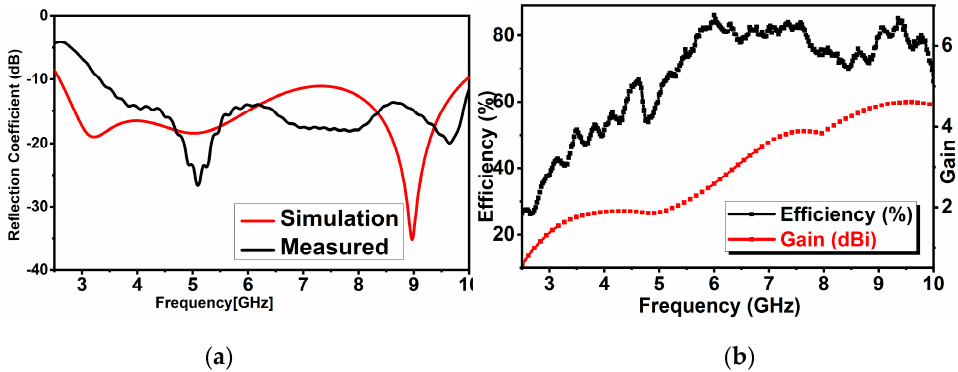
Figure 5. ( a ) Reflection coefficient (S 11 ). ( b ) Peak gain and efficiency (measured).